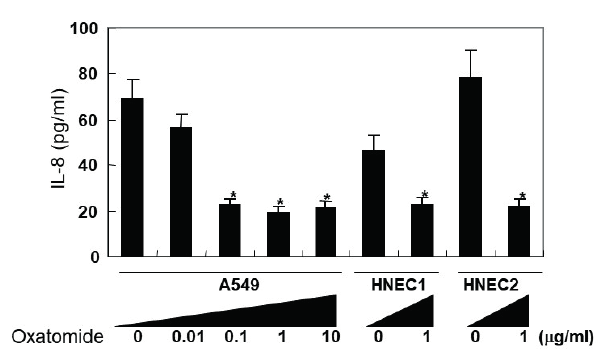
Figure 3. Effects of oxatomide on IL-8 release from A549 and HNECs. Confluent monolayers of A549 or HNECs cells were pre-incubated with oxatomide (0.01-10μg/ml) or PBS (control) for 30 min and then activated with lipoprotein(1μg/mL). *P <